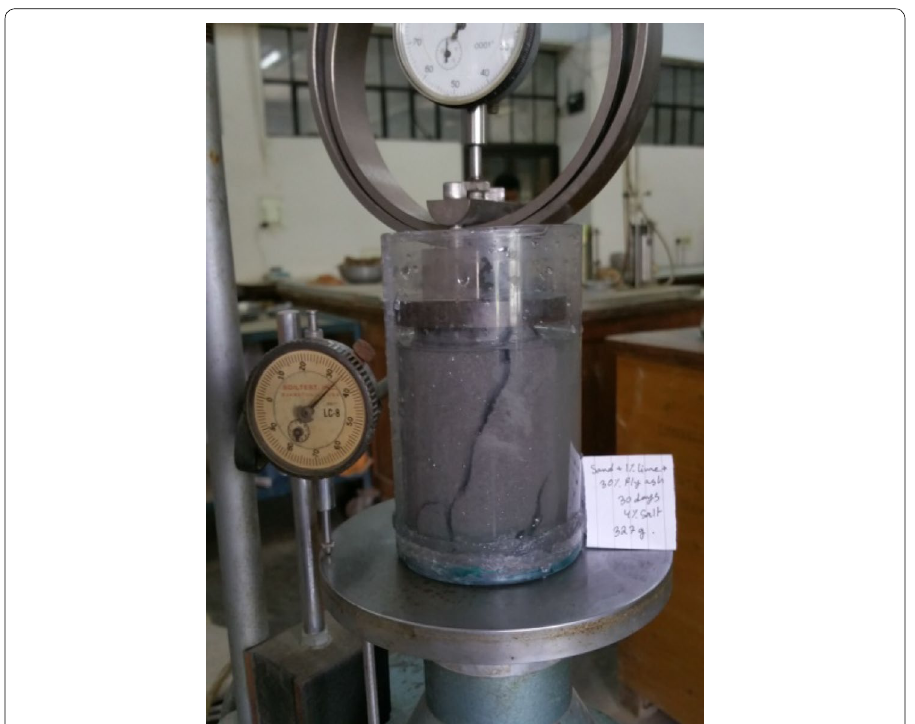
Fig. 5 Submerged specimen for unconfined compression